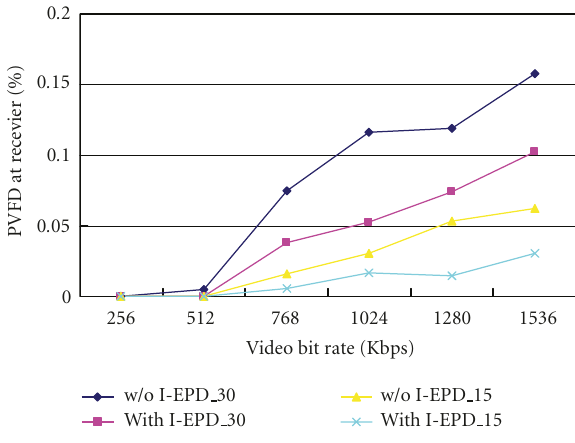
Figure 10: PVFD R versus video bit rates.